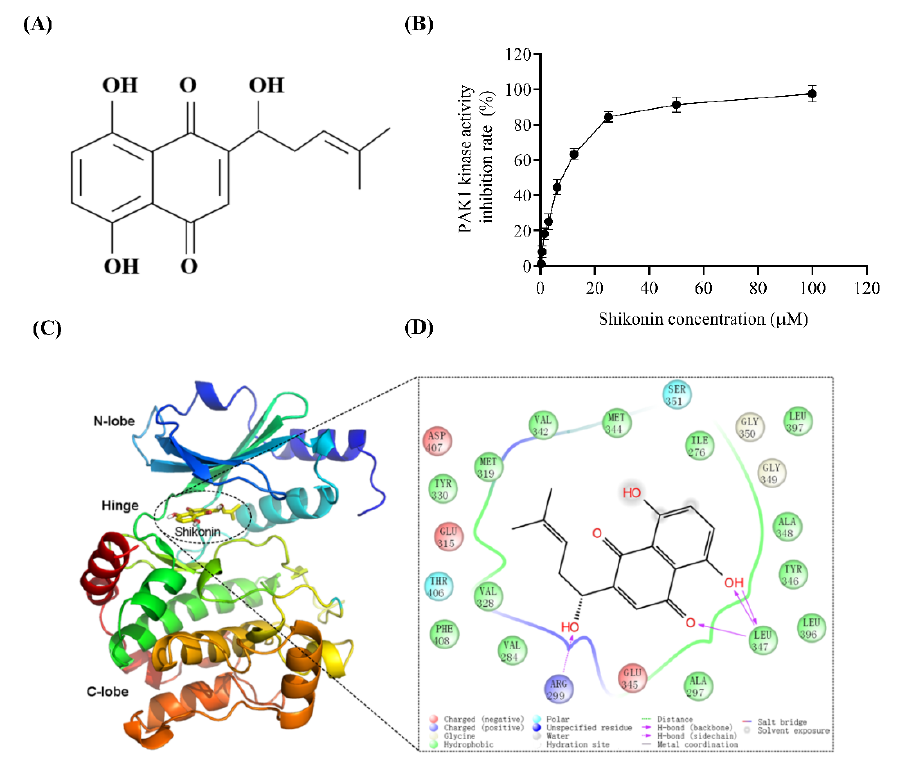
Figure 2. Shikonin binds to ATP pocket of PAK1. ( A ) Structure of shikonin. ( B ) Human PAK1 protein was incubated with shikonin at indicated concentrations and kinase activity was measured. Results are means ± SD of three independent experiments. ( C ) Molecular docking of shikonin and ATP pocket of PAK1. ( D ) Specific binding mode of shikonin and PAK1.